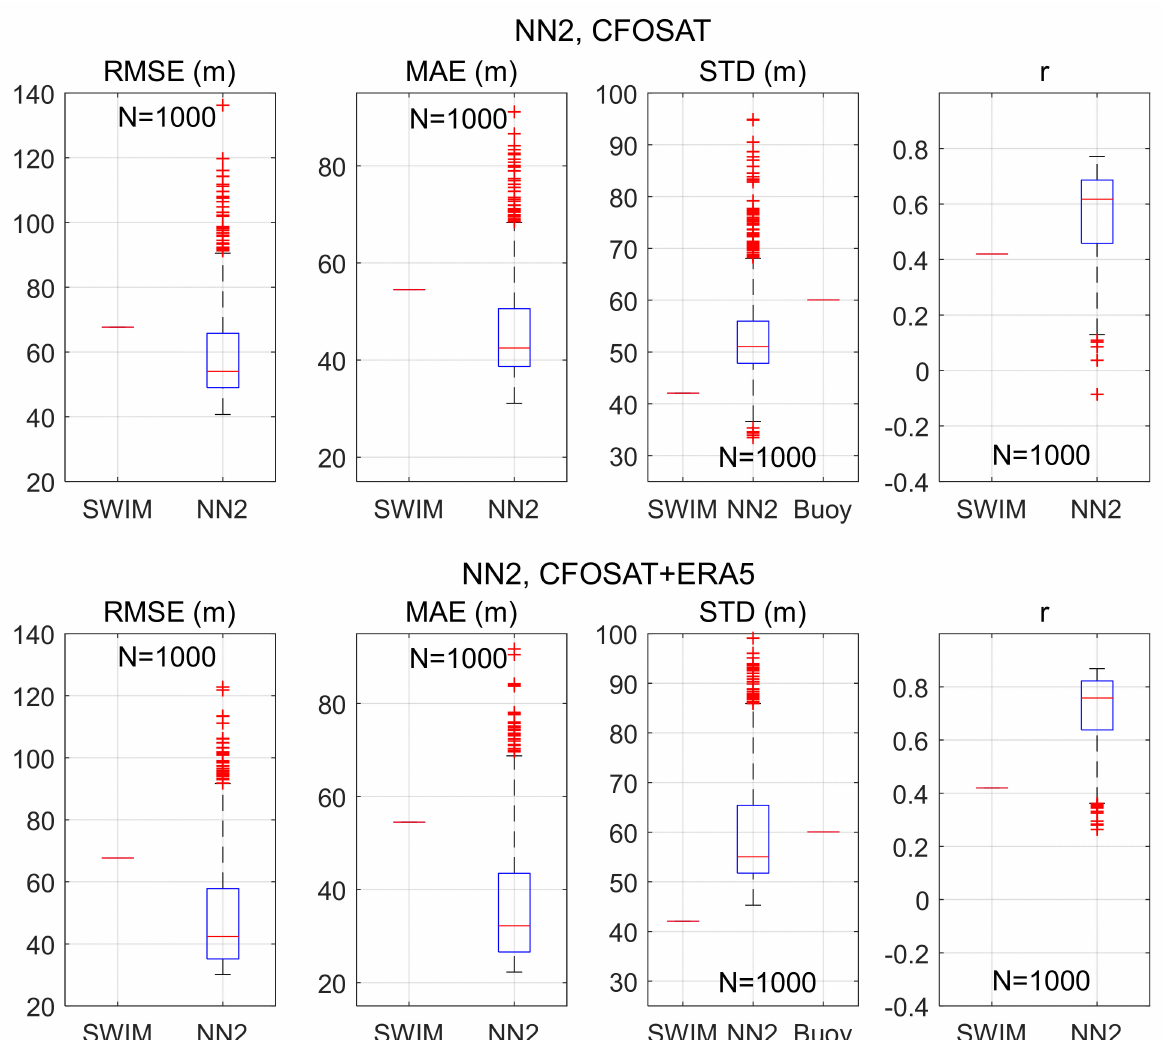
Figure 13. Boxplots of the RMSE, MAE, STD, and r of the SWIM dominant wavelengths and the validation results of the NN2 models at buoy B. The upper panels show the self-calibration results with CFOSAT parameters, and the lower panels show external-source calibration in which both CFOSAT and ERA5 parameters are included. The NN2 models are established by the Monte Carlo experiments based on the data at buoy A. Points in red “+” are drawn as outliers if they are larger than the maximum (Q3 + 1.5 × (Q3 − Q1)) or smaller than the minimum (Q1 − 1.5 × (Q3 − Q1)), where Q1 and Q3 are the 25th and 75th percentiles,